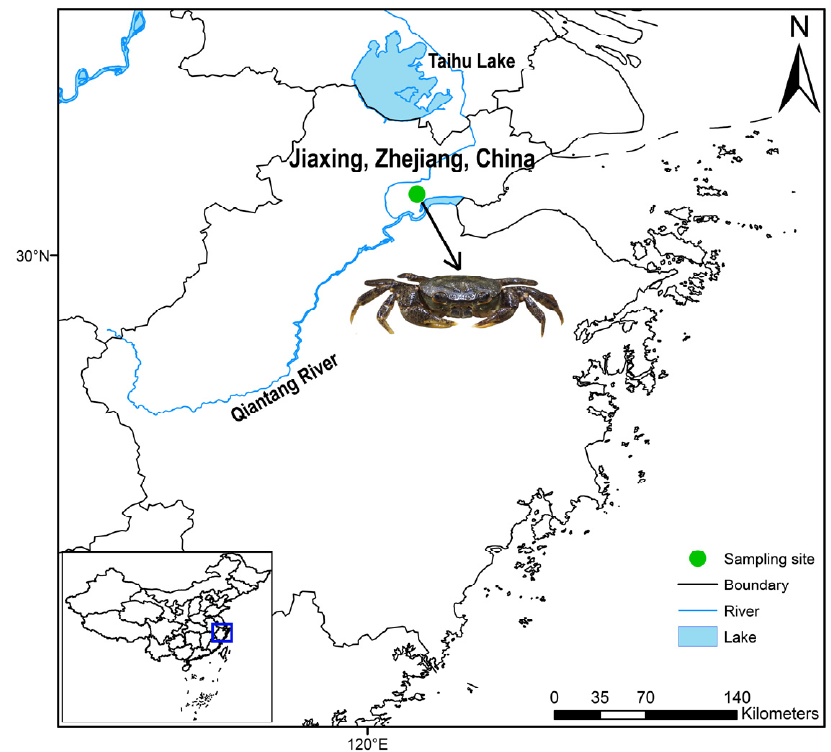
Figure 1. The sampling site and photo of Sinopotamon planum (Authors’ own).